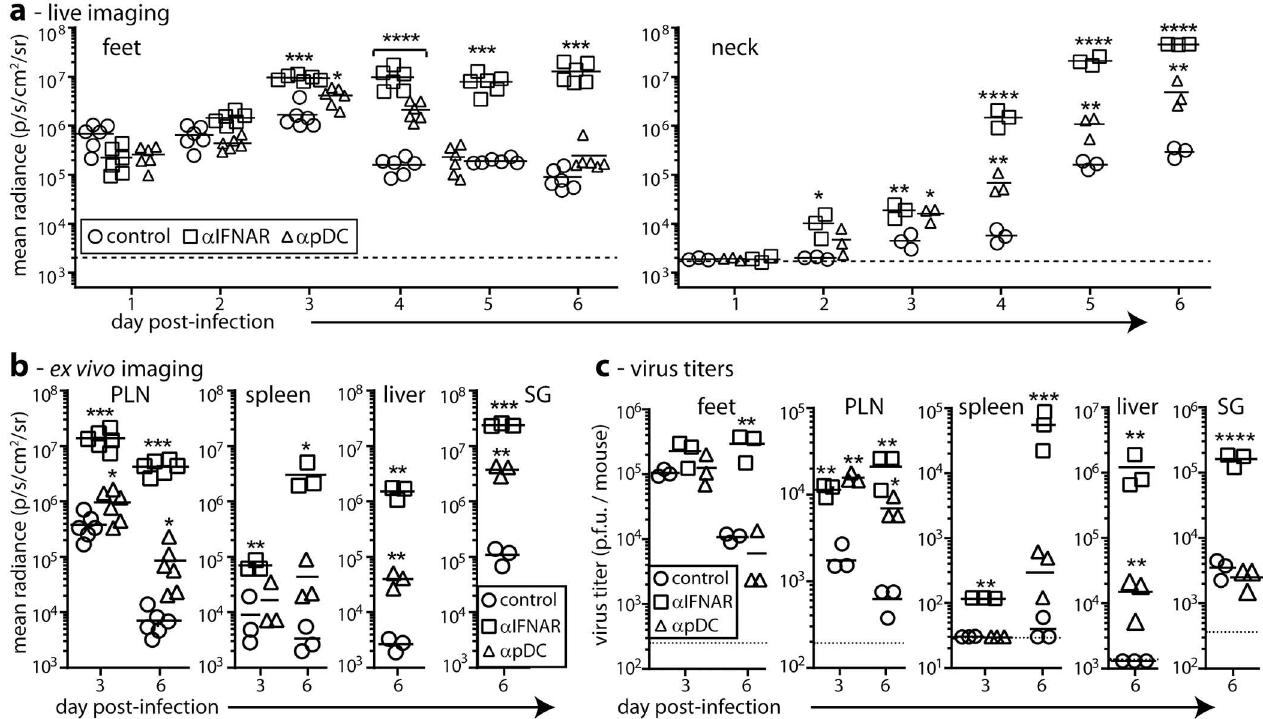
Fig 1. IFNAR blockade increases MCMV dissemination from a peripheral site. (a). BALB/c mice were given IFNAR blocking( α IFNAR) or pDC depleting( α pDC)antibodiesin PBS, or PBS only (control), then givenMCMV-LUCi.f. (10 6 p.f.u.). We tracked infection by luciferininjectionand live imagingof light emission (radiance= photons/sec/cm 2 /steradian). Bars show means, other symbols show individuals.Both α IFNAR and α pDC significantly increasedluciferasesignalsin the feet (footpad+ PLN) and in the neck (salivary gland)from day 3, with α IFNAR having a significantly greater effect. After day 4, α pDConly affected neck signals. (Student’s two-tailedunpairedt-test; * p < 0.05, ** p < 0.01, *** p < 0.001, **** p < 0.0001). The dotted lines show assay sensitivitylimits. (b). Mice were treated and infected as in ( a) , and organs harvested3 or 6 days later for ex vivo luciferaseimaging.Liver and salivary glandsignalswere not detected at day 3. The Y axis baselinescorrespondto assay sensitivity limits. Significantsignalsabovethe controlsare indicatedaccordingto the scheme in ( a) . ( c). The organs from ( b) were plaqueassayed for infectious virus. Bars show means, other symbols show individualorgans. Dotted lines show assay sensitivity limits where abovethe Y axis baseline.Titers significantly above those of controls are indicated. Significantsignalsabovethe controlsare indicatedaccordingto the scheme in ( a) .